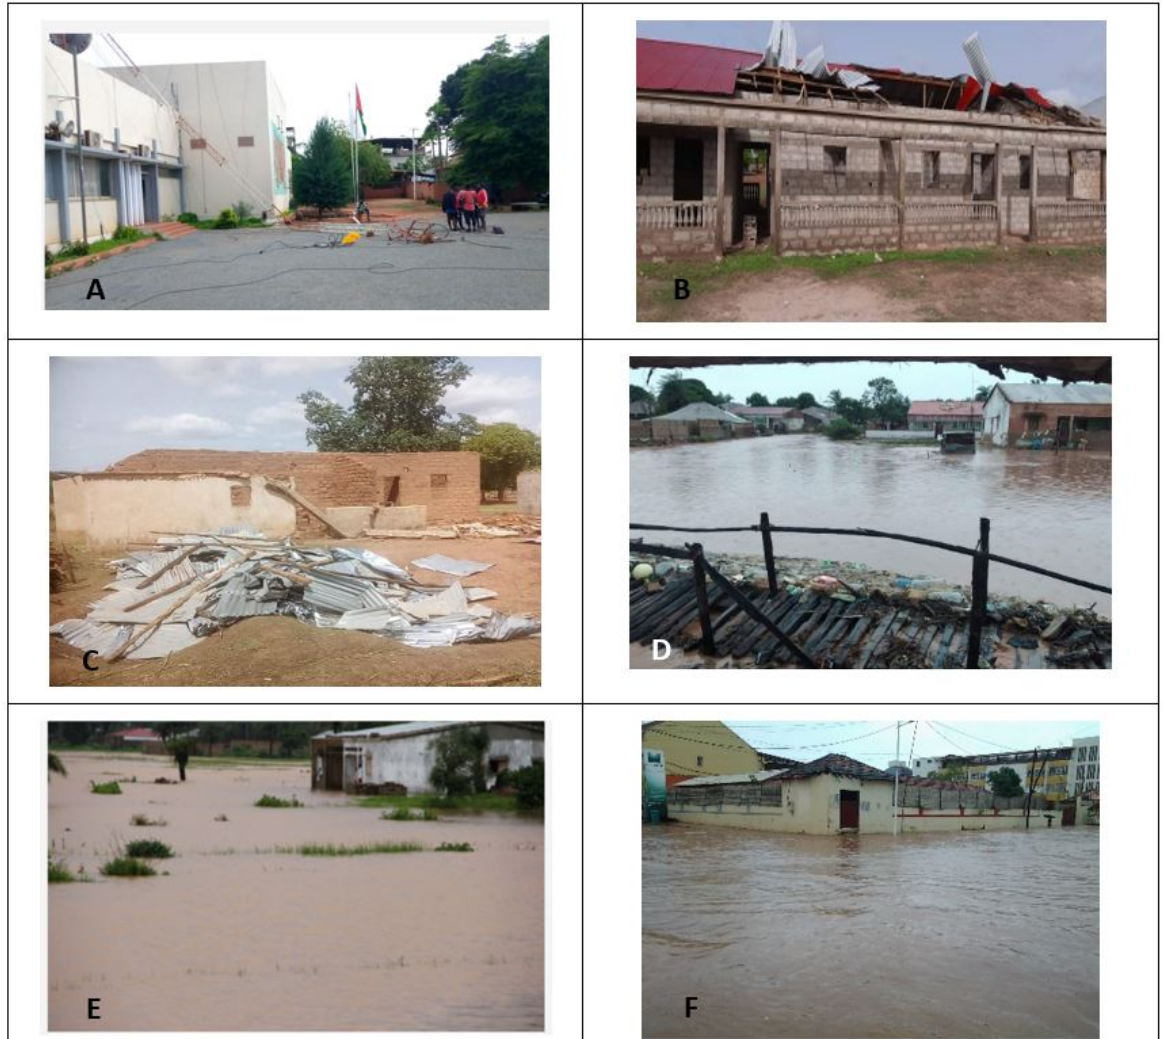
Figure 9. Flood damage in Bissau. ( A )—TVGB repair work after damage caused by rain and strong winds; ( B , C )—Effects of strong winds in Bissau suburbs; ( D – F )—Flooded houses in the outlying neighborhoods of the city of Bissau. Sources: O Democrata GB, VISÃO, and SNPC.